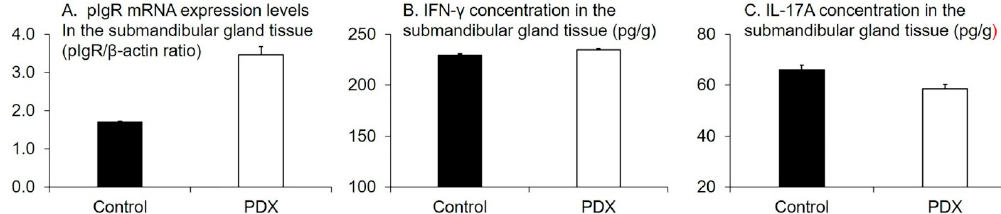
Figure 4. Effects of polydextrose (PDX) addition on the polymeric immunoglobulin receptor (pIgR) mRNA expression levels in the submandibular gland tissue ( A ), the interferon γ (IFN- γ ) concentration in the submandibular gland tissue ( B ), and the interleukin 17A (IL-17A) concentration in the submandibular gland tissue ( C ). n = 6 per group. Data are expressed as means (histogram bars) and SEM (error bars). pIgR mRNA expression levels in the submandibular gland tissue in the PDX group was higher than that in the control group ( p = 0.02, Welch’s t- test). We found no significant differences in IFN- γ and IL-17A concentration in the submandibular gland tissue between the two groups ( p = 0.8 and 0.3, respectively, Welch’s t- test).